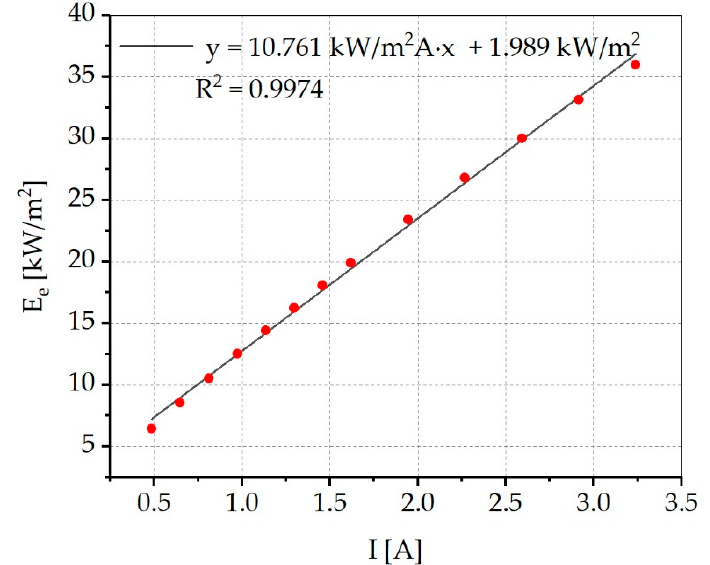
Figure 8. Mean irradiance in the sample area for different currents. The irradiance increases by about 10.7 kW/m 2 per ampere.